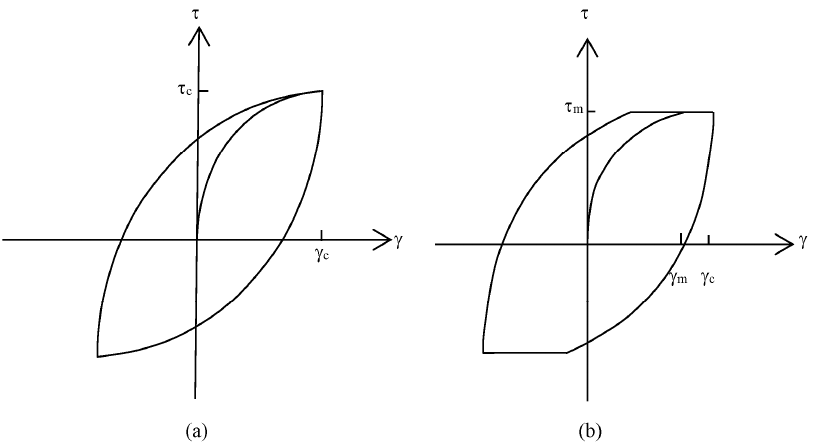
Figure 1. Shear stress–strain loops: ( a ) Hardin/Drnevich hysteretic damping, ( b ) Mohr–Coulomb model with Hardin/Drnevich hysteretic damping.